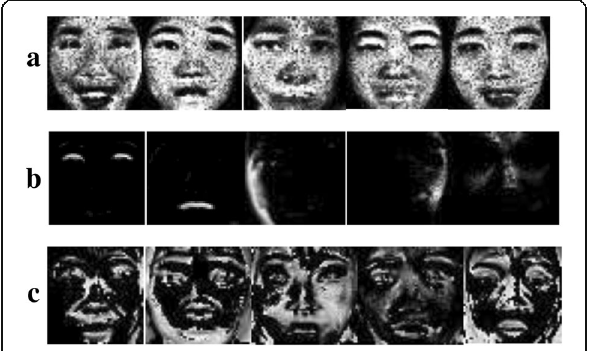
Fig. 3 Learned basis images by a NMF, b proNMF, and c the proposed proCMF from the training data of the JAFFE dataset